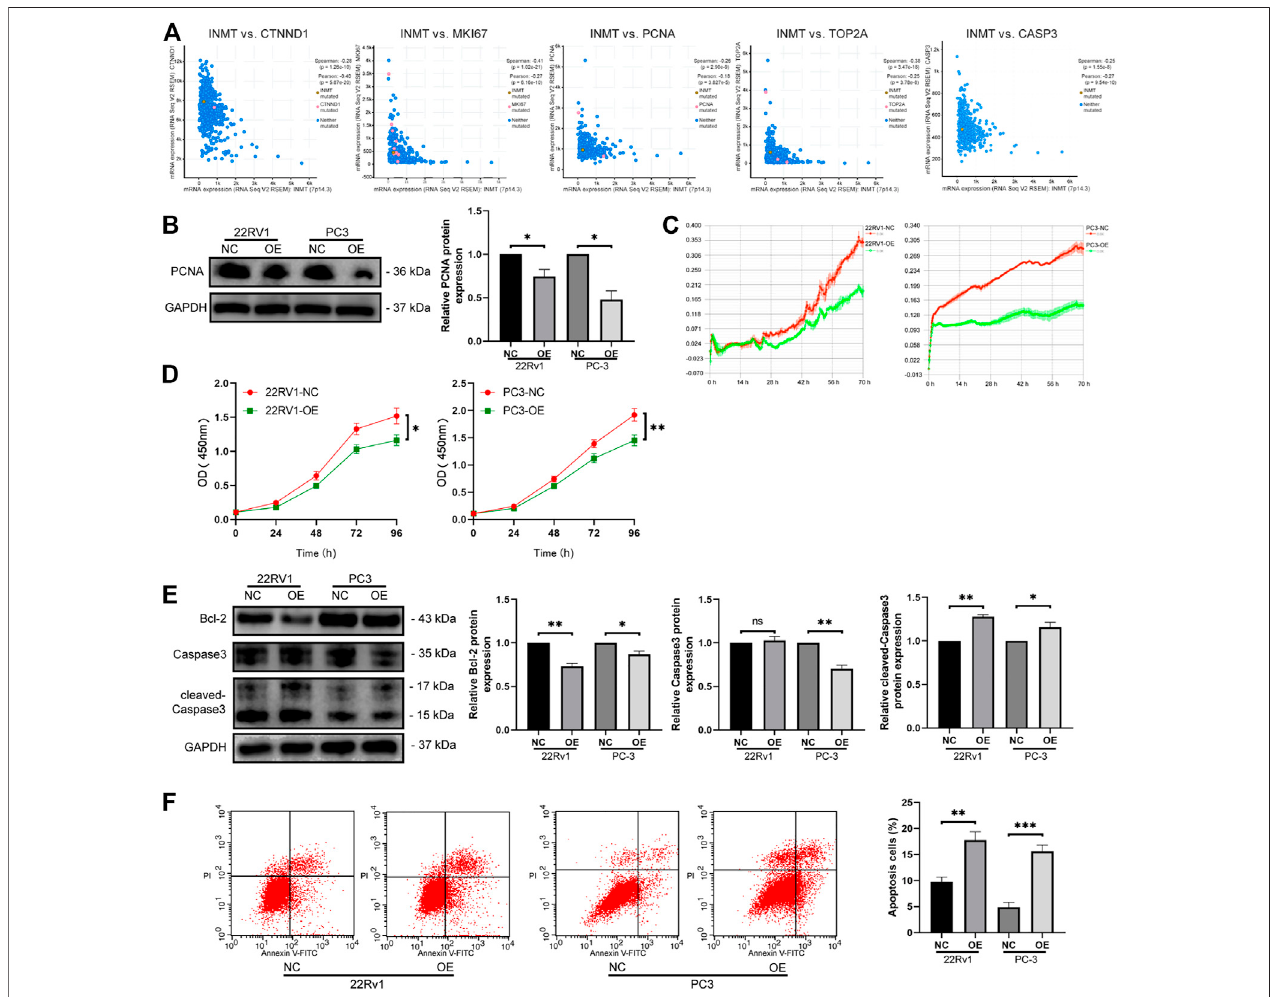
FIGURE 4 | Overexpression of INMT inhibited cell activity and proliferation and promoted apoptosis. (A) Correlation between INMT and proliferation-related genes ( CTNND1 , MKI67 , PCNA , TOP2A )andapoptosis-relatedgene. (B) PCNAproteinlevelsweremeasuredusingwesternblotting. (C) OverexpressionofINMTsuppressed cell viability according to the RTCA assay. (D) The effect of INMT overexpression on cell proliferation was determined using the CCK-8 assay. (E) Bcl-2, caspase 3, and cleaved caspaase3 protein levels were measured using western blotting. (F) Apoptosis was measured using fl ow cytometry in 22Rv1 and PC-3 cells after INMT